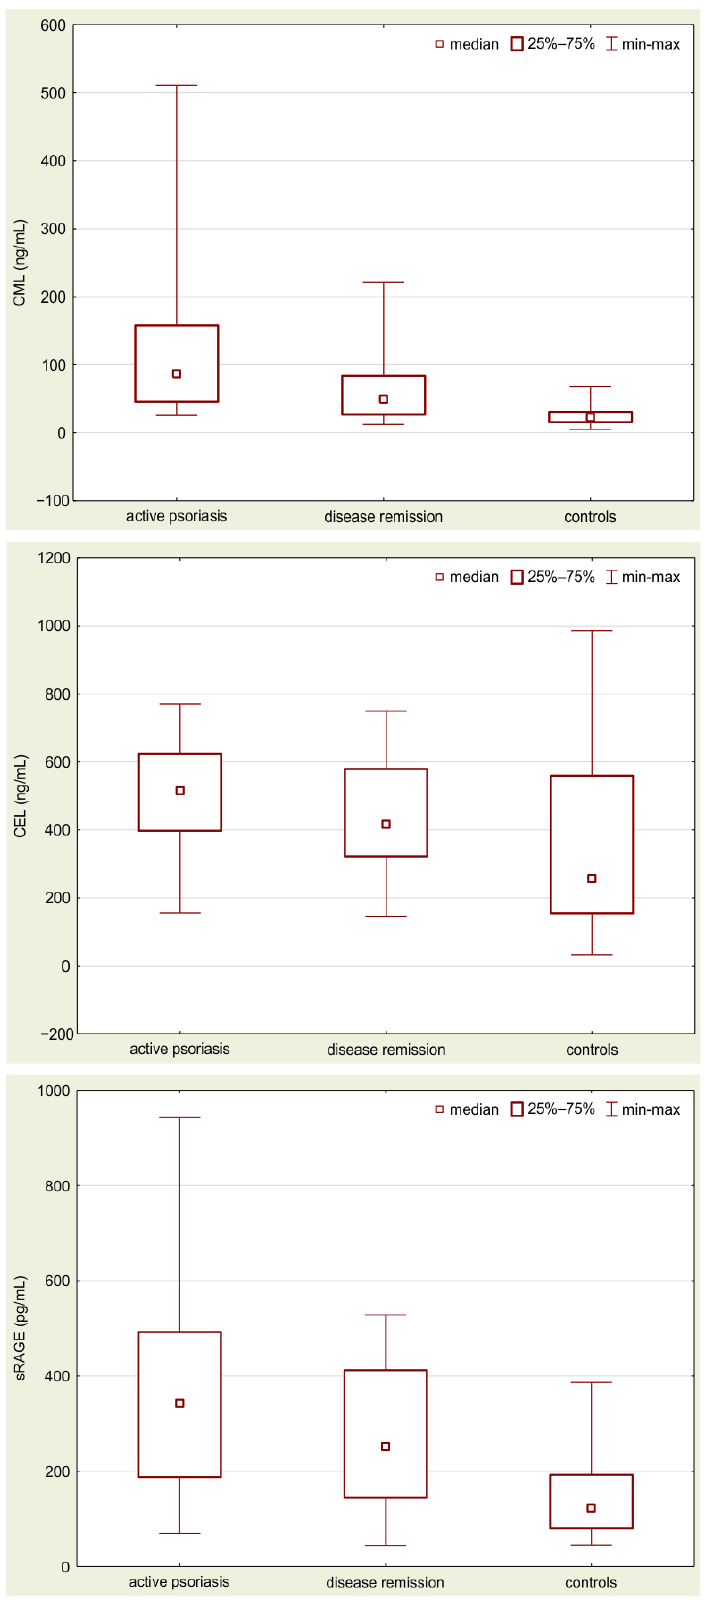
Figure 1. Concentrations of CML, CEL, and sRAGE in sera samples obtained from the patients with active disease, at the remission stage, and from the healthy controls.